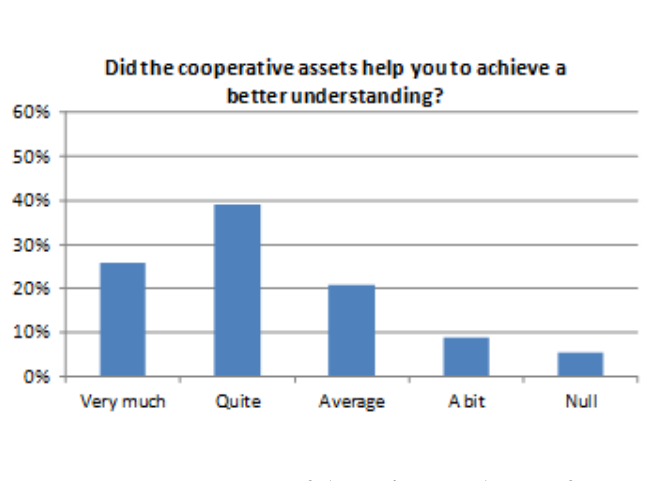
Figure 11. Opinion of the students on the use of cooperative